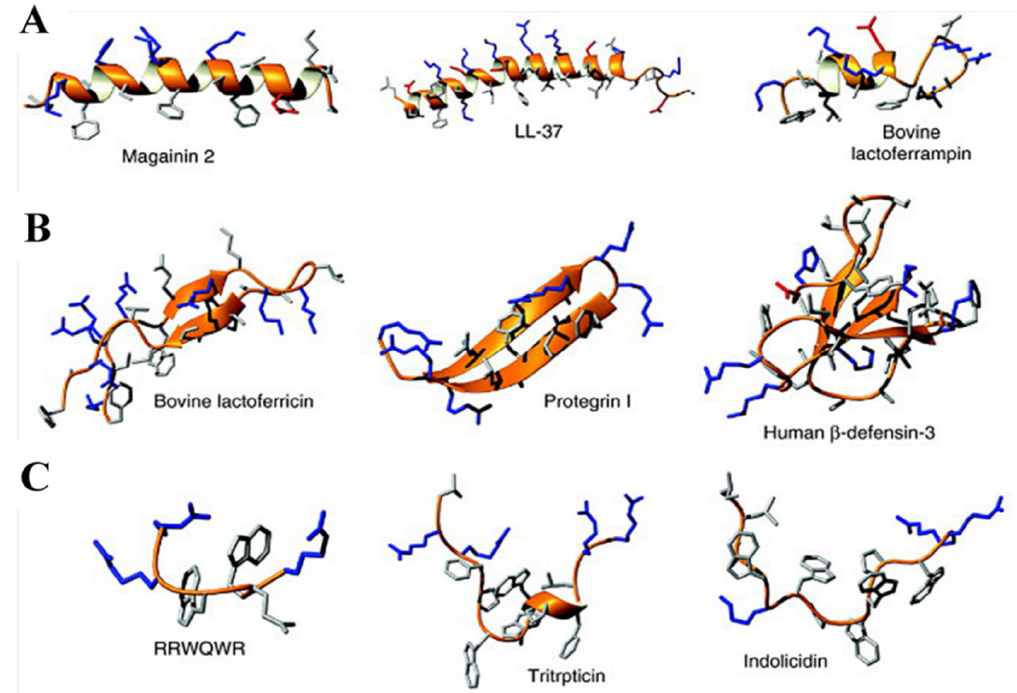
Figure 4. An overview of the major structural classes of AMPs. ( A ) α -Helical peptides, ( B ) β -sheet peptides, and ( C ) extended peptides. Copyright (2021) Elsevier [32].